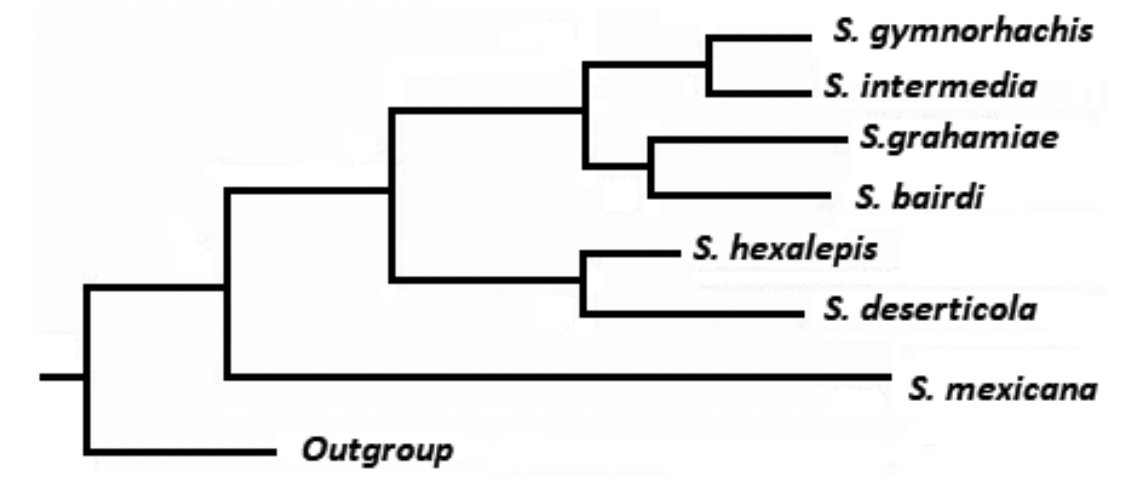
Fig. 1. Molecular phylogenetic tree modified from Hernández-Jiménez et al